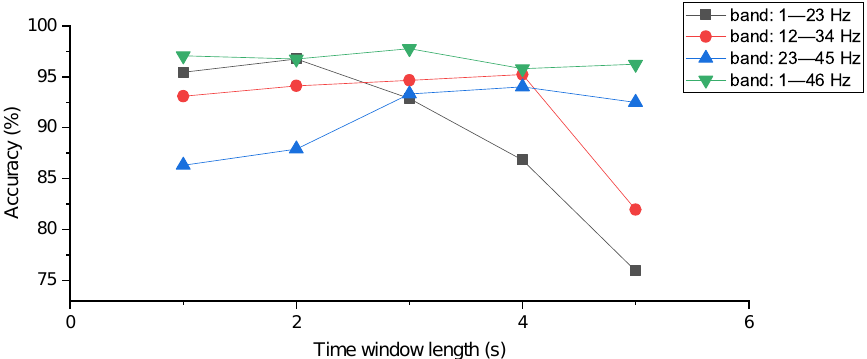
Figure 7. The selection of the frequency bands. Accuracy obtained by combining different frequency bands with different time window